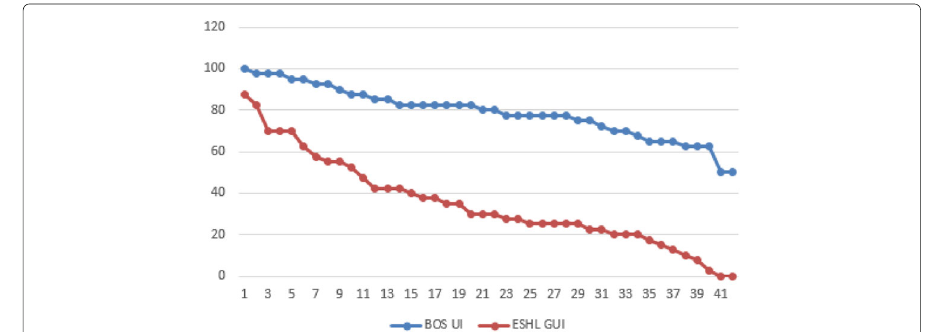
Fig. 40 The SUS scores of the BOS UI and the ESHL GUI from the 42